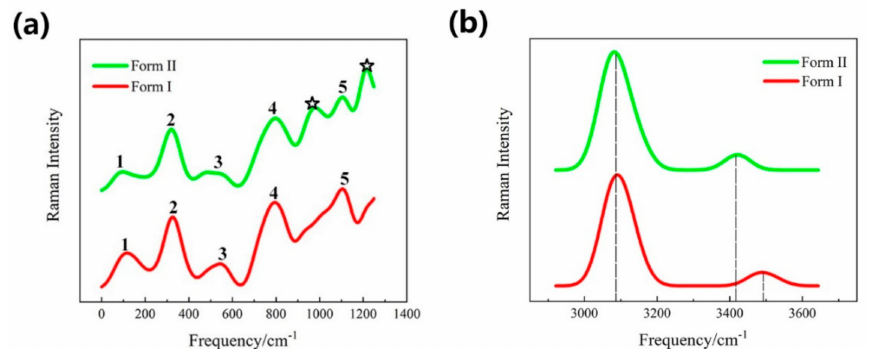
Figure 4. The comparison of Raman spectra of β -lactam form I (red curves) and form II (green curves) under standard atmospheric pressure (100 KPa) in low-frequency ( a ) and high-frequency ( b ) regions, respectively. The characteristic peaks for form II are labeled by the black star signs.